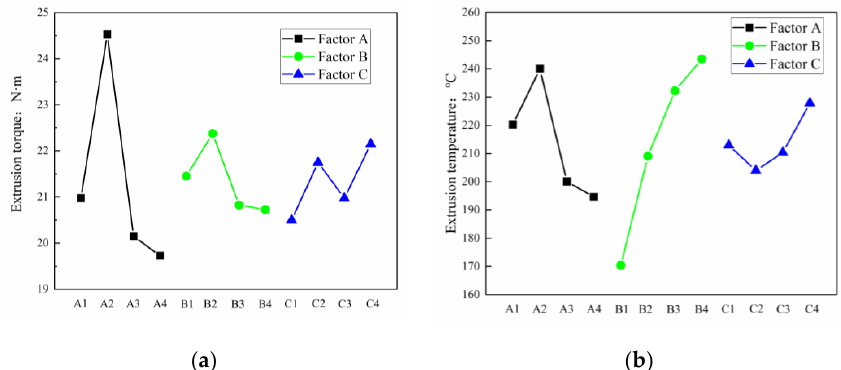
Figure 8. The influence of various factors on the extrusion torque ( a ) and the influence on the extrusion temperature ( b ).